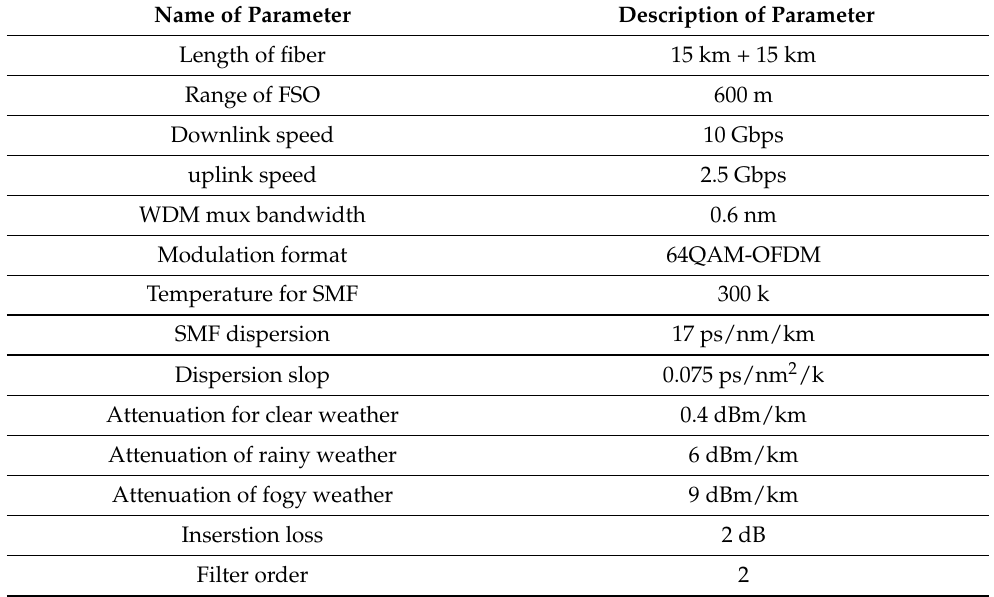
Table 1. List of required parameters for evaluating the hybrid WDM-FSO